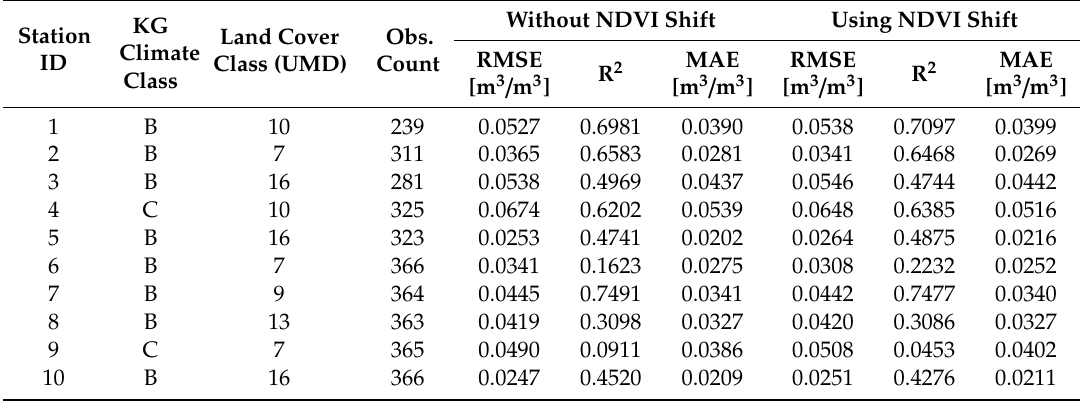
Table A1. Five-fold cross-validation metrics aggregated over 10 independent splits for each